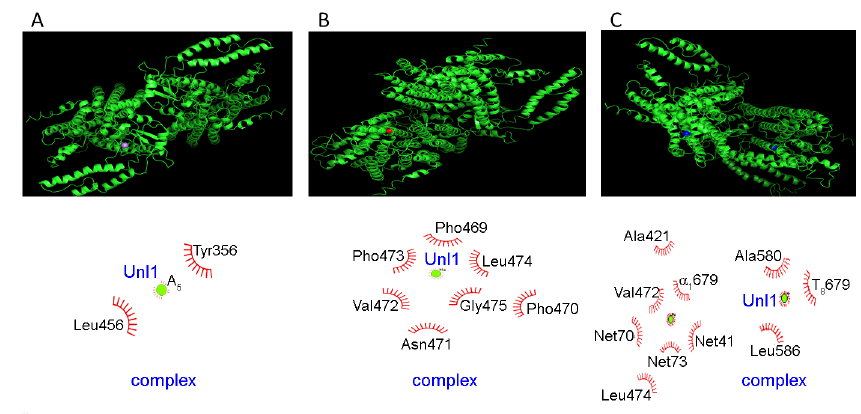
Figure 7. Molecular interaction of transport protein of O. sativa (6OCE) (A) As 3+